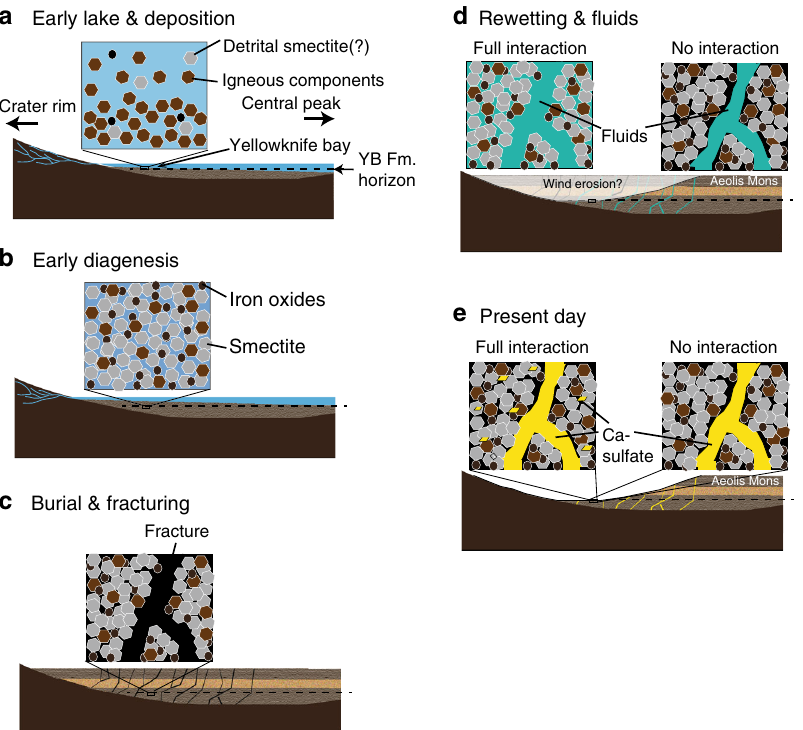
Fig. 1 Illustrations of hydrogeological context of Yellowknife Bay Formation at Gale Crater (from a – e in time sequence). The dashed lines show the horizon of Yellowknife Bay Formation. In d , e , the full- and no-interaction scenarios are compared. See the main text for the details and